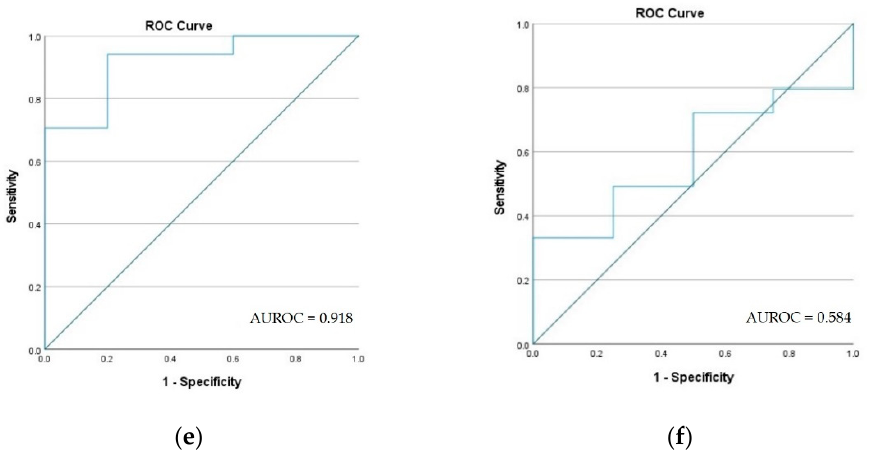
Figure 11. Relative operating characteristics (ROC) curve and AUROC value for degraded ecosystems. ( a ) Forest ecosystems; ( b ) grassland ecosystems; ( c ) cave ecosystems; ( d ) river ecosystems; ( e ) lake ecosystems; ( f ) coastal ecosystems.